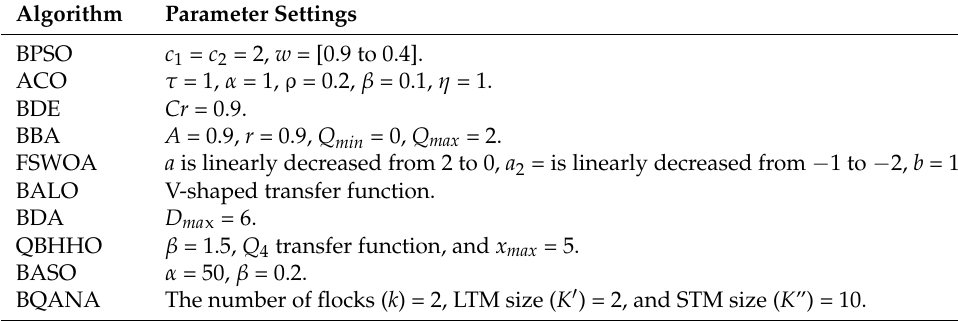
Table 4. Parameters of the